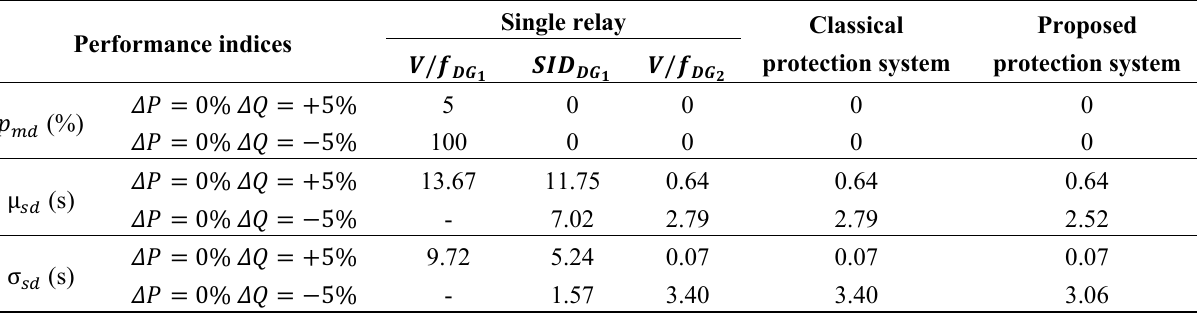
Table 14. Comparison between the classical and the proposed protection systems in the Case D. Single relay Classical Performance indices protection system